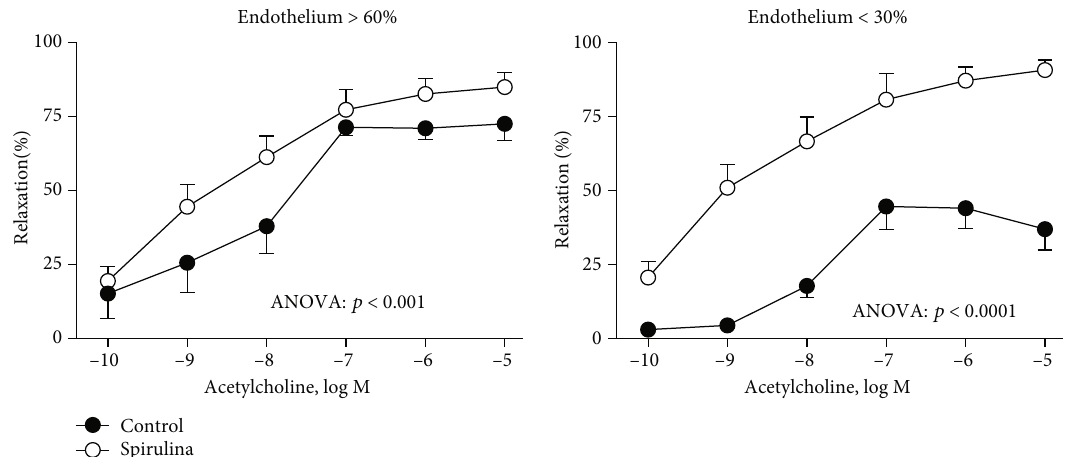
Figure 1: E ff ect of the aqueous Spirulina extract incubation on the concentration-response curve to acetylcholine in aortic segments, with di ff erent amounts of functional endothelium, from SHR. Results ( means ± SEM ) are represented as the percentage of inhibition of the contraction elicited by 0.1 μ M noradrenaline. Number of animals: 5-7. The statistical signi fi cance is indicated in the corresponding